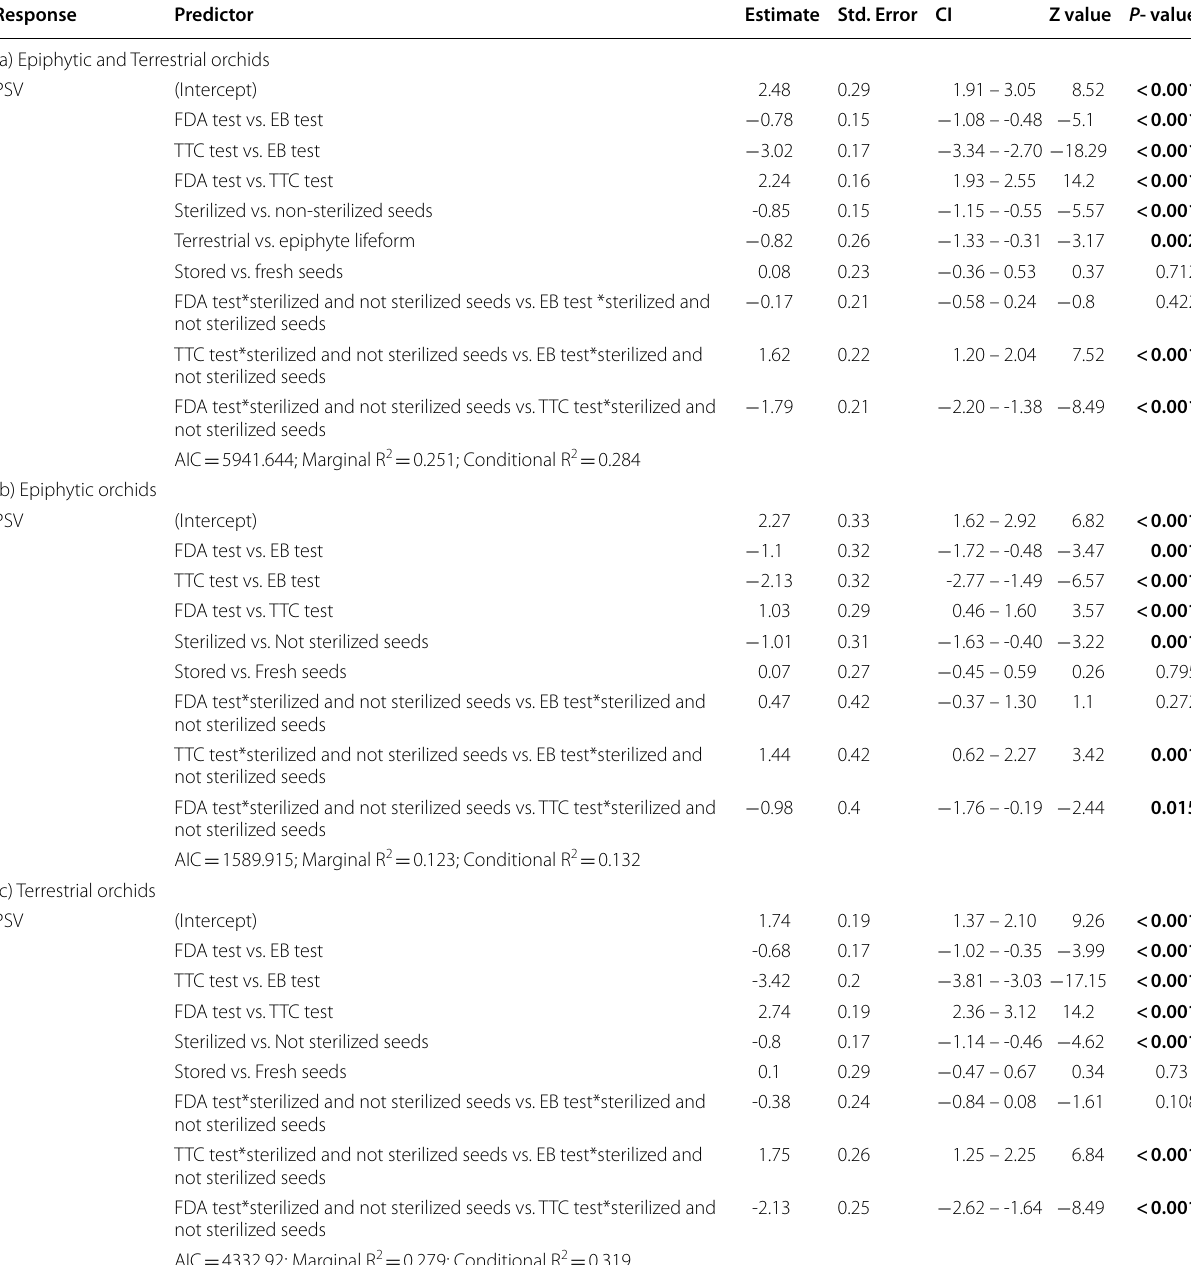
Table 2 The results of response of PSV with three viability tests of epiphytic and terrestrial orchids